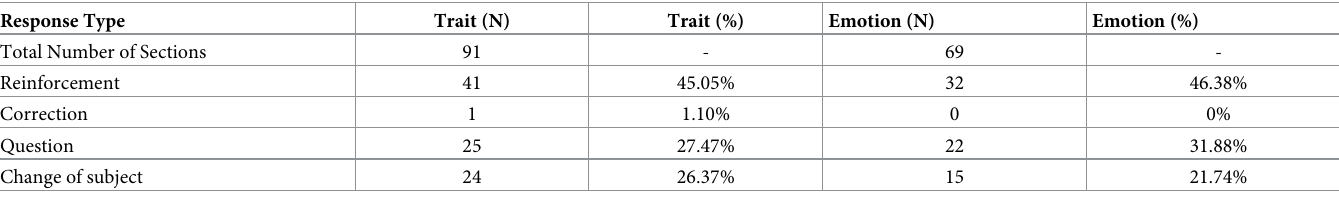
Table 2. Study 1: Frequency of parents’ responses to child trait discussion by response type.